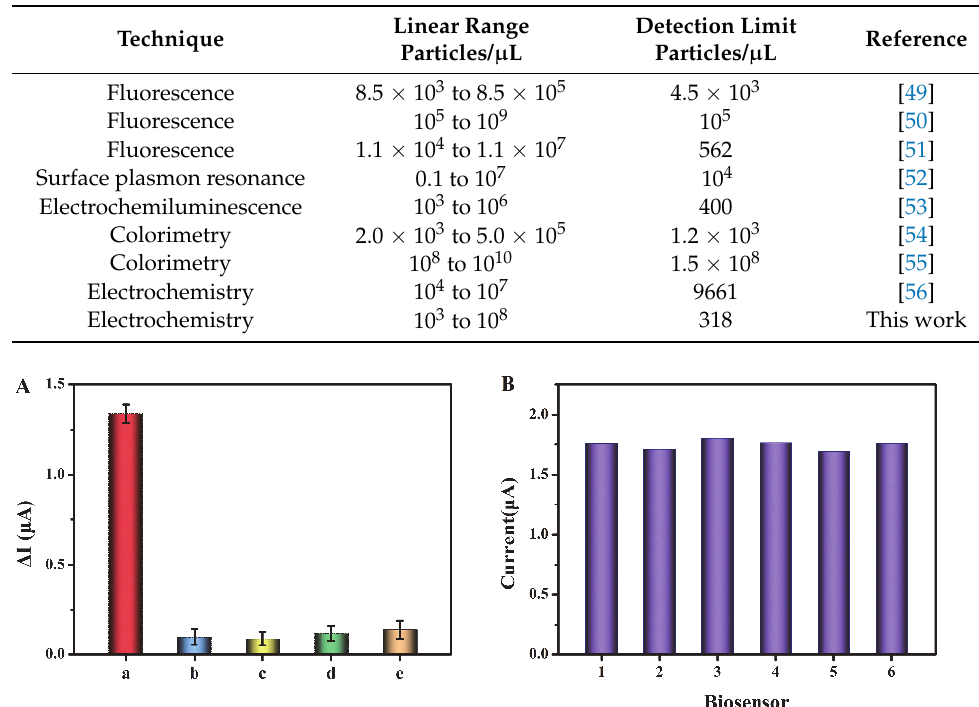
Figure 4. ( A ) Current curves for different concentrations of exosomes. a–g are 0, 10 3 , 10 4 , 10 5 , 10 6 , 10 7 , and 10 8 particles/ µ L, respectively. ( B ) The linear relationship between the current intensity and the logarithm of exosome concentration. Table 1. Comparison of the developed method with some other reports.